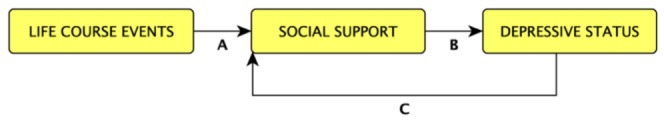
Conceptual framework.Events in the late-life events of the elderly person modify the social support they receive from different actors (A), which impacts their depressive status (B). In turn, this depressive status changes the social support they receive, creating a loop effect (C).